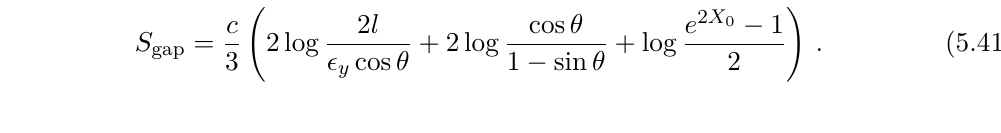
Figure 21. The reflected entropy between radiation and radiation (in the unit of c to time T for X 0 = 1 . We pick X 1 = 30 , θ = π time evolution of the final reflected entropy while the dotted line represents the result for the first phase. Note that the R-R reflected entropy jumps at Page time with a gap given by (5.41) in the limit X 1 → ∞